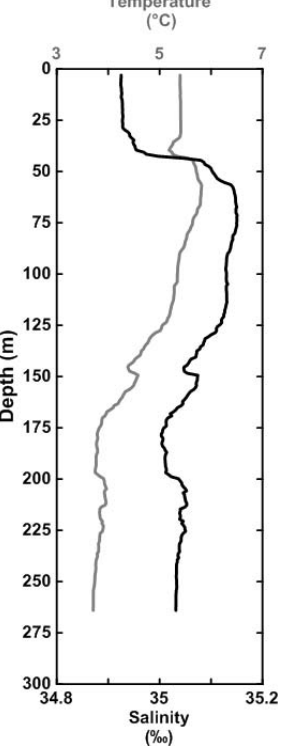
Fig. 2. Temperature (grey) and salinity (black) profile from the JM09-KA11-GC core location measured on 13 July 2009 (GlaciBar).